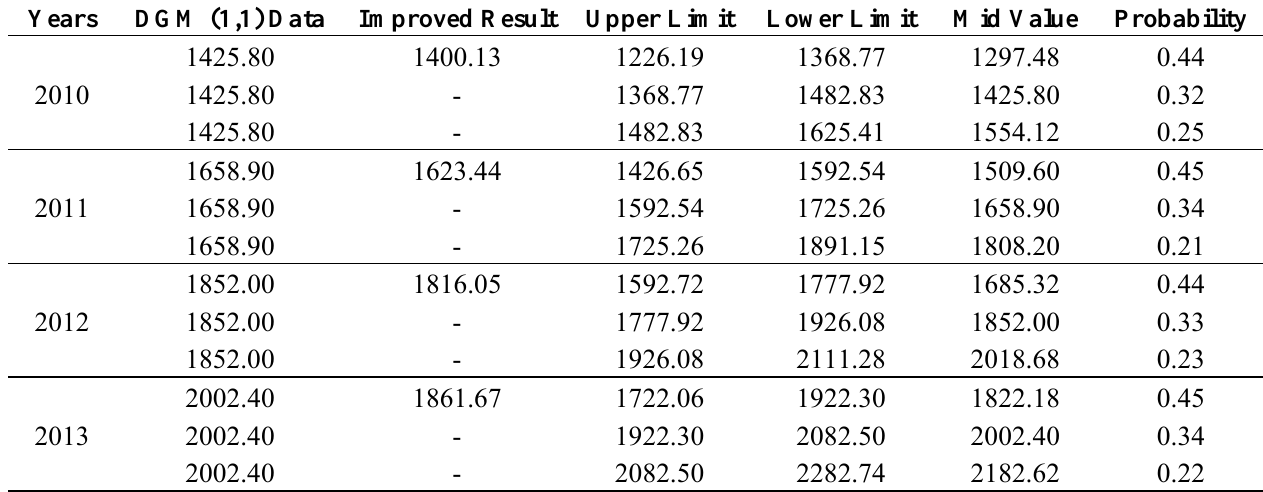
Table 7. Improved results with the Markov chain